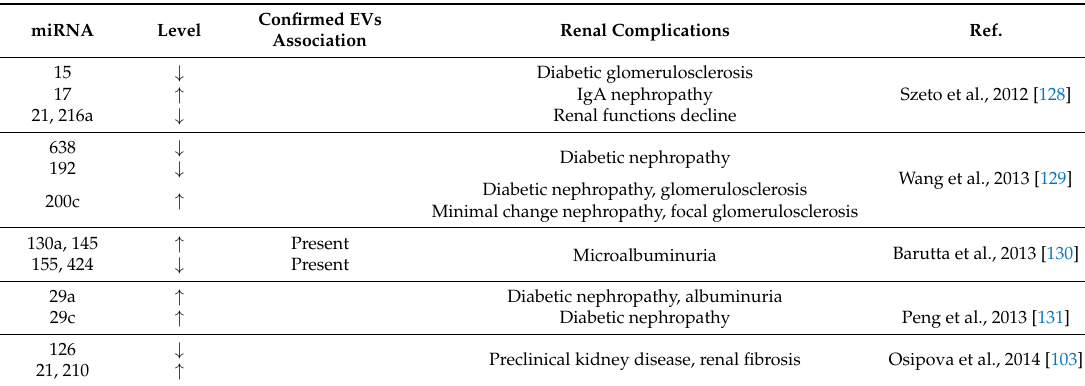
Table 2. miRNAs and EV-associated miRNAs in patients with diabetic renal involvement. Most frequently detected miRNAs signature detectable in urine of patients with DN at different stages of